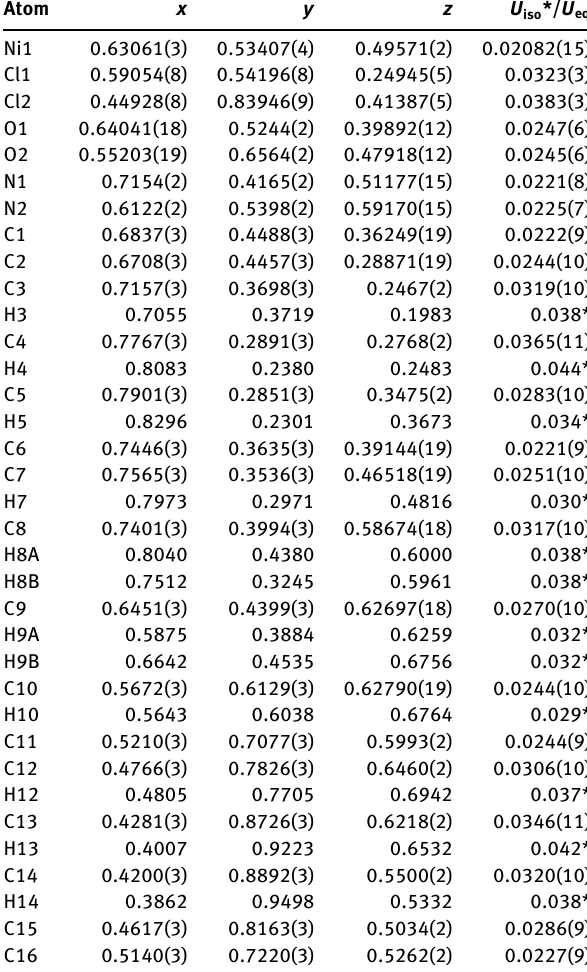
Table 2: Fractional atomic coordinates and isotropic or equivalent isotropic displacement parameters (Å 2